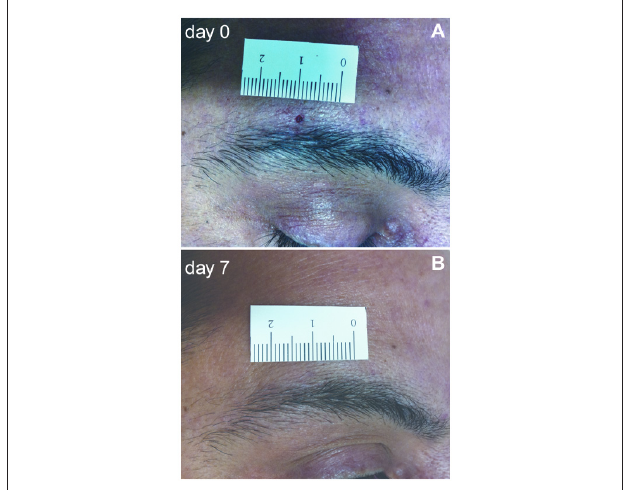
FIGURE 1 | Two-mm supraorbital punch skin biopsy. (A) Photograph of a patient with postherpetic neuralgia (PHN) showing the 2-mm skin wound immediately after the punch. (B) After 1 week, the scar is hardly